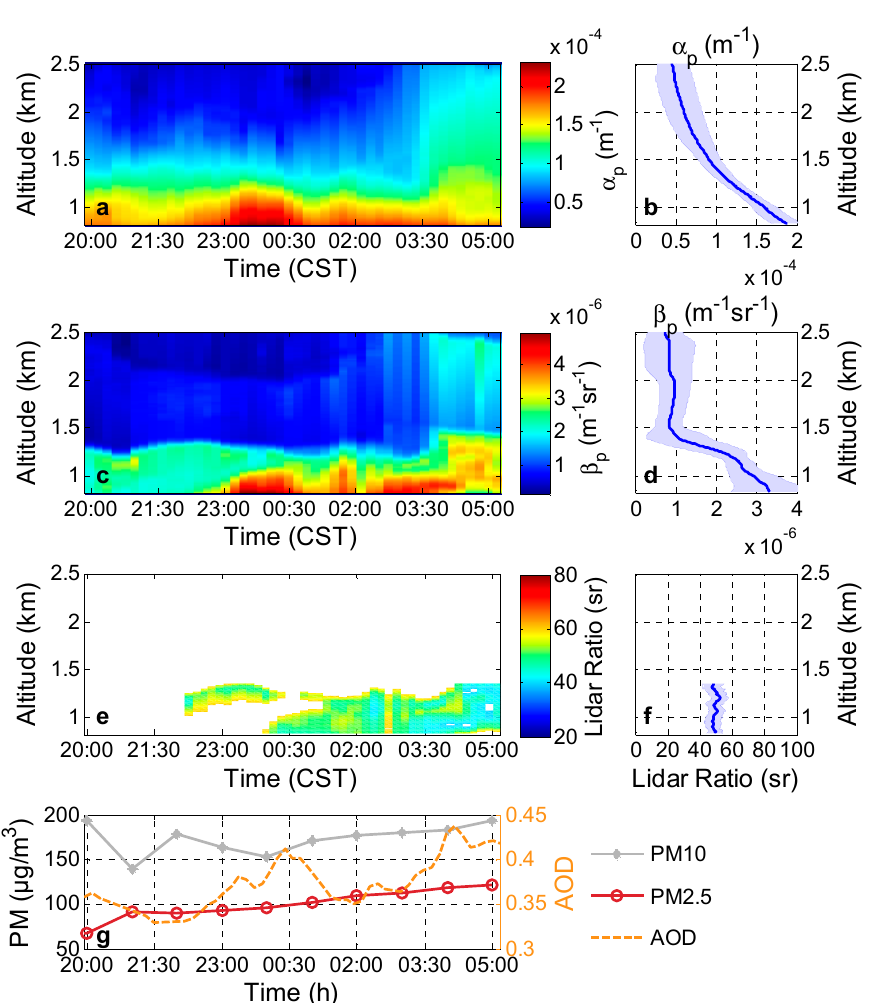
Figure 3. Moderately polluted cases: ( a ) particle extinction coefficients ( α p ); ( c ) particle backscatter coefficients ( β p ); respective ( e ) lidar ratios at 532 nm measured in Wuhan on 1–2 December 2013, at 2000–0520 CST; ( b ) mean particle extinction coefficients; ( d ) backscatter coefficients; respective ( f ) lidar ratios from 20:00 to 05:20. The blue shadows on each figures indicate the standard deviations of corresponding values; ( g ) The PM 10 and PM 2.5 as well as the AOD retrieved from the Raman lidar.